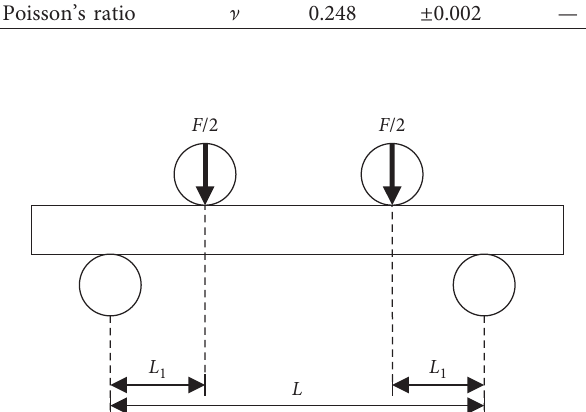
Figure 11: Four-point bending experimental setup.